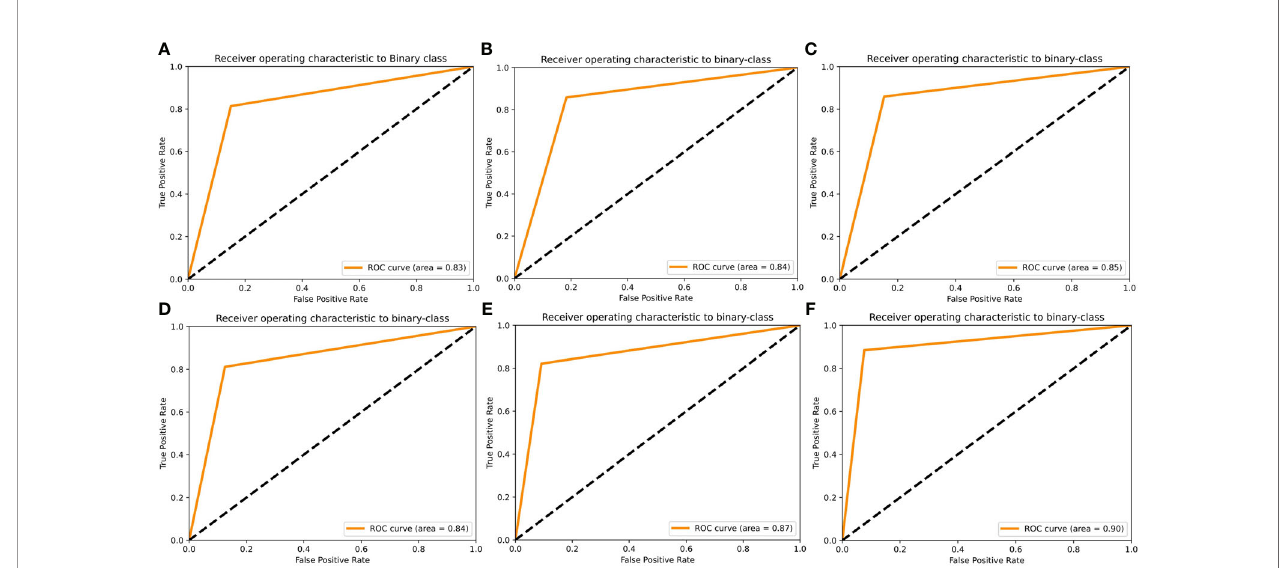
FIGURE 4 | Receiver operating characteristic (ROC) curves of the 6 AI models using the validation set. ROC curves are shown for (A) Res101, (B) VGG16, (C) Res50, (D) In_Res, (E) EB5, and (F)